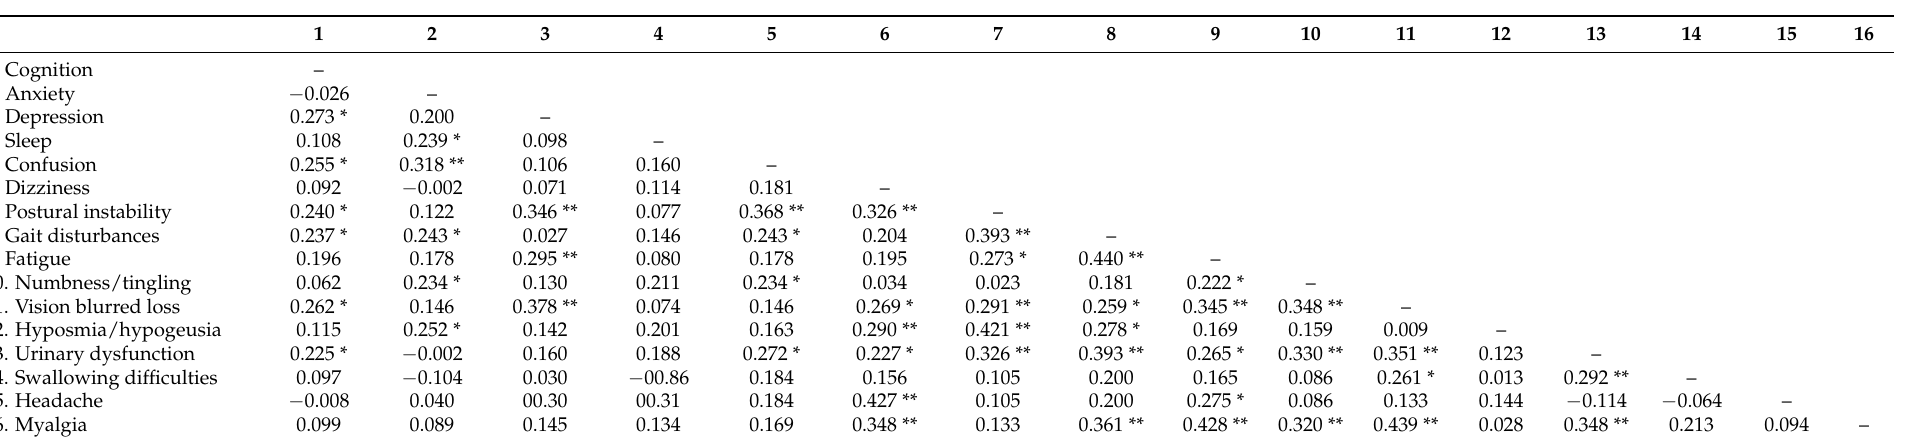
Table 1. Kendall’s TAU correlation between the